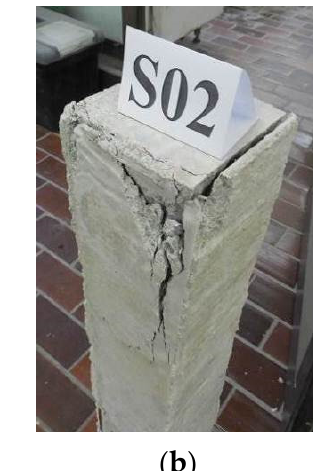
Figure 7. Column models after the experiment. Table 4. Ultimate load forces of column models. Control Group